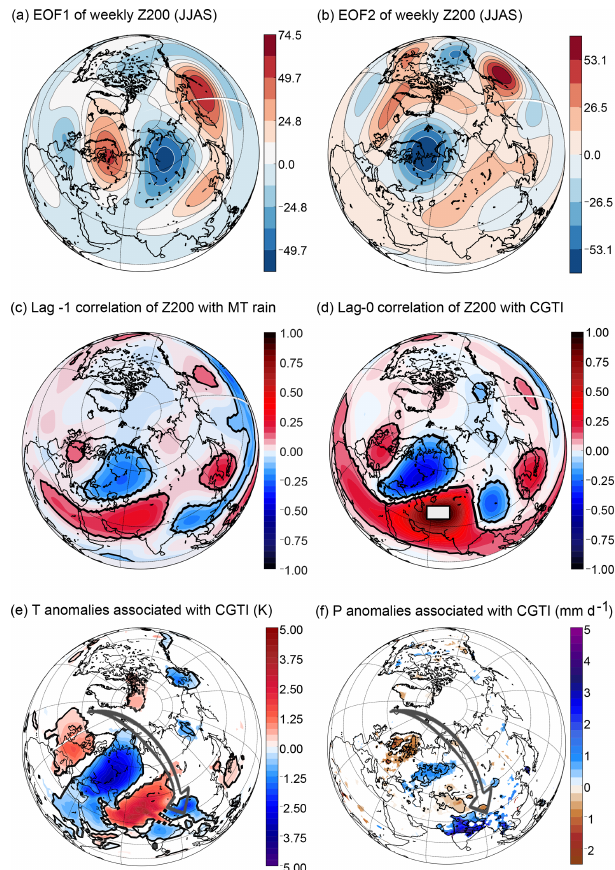
Figure 2. Mid-latitude variability associated with the ISM. (a, b) EOF1 and EOF2 expressed as covariance for the JJAS weekly Z200 field in the Northern Hemisphere (0–90 ◦ N, 0–360 ◦ E) for the period 1979–2017. (c) Correlation between weekly MT rain- fall (lag = 0) and Z200 (lag = − 1 week). (d) The CGTI region (white box) and the correlation between CGTI and Z200 (both at lag = 0), which forms the circumglobal teleconnection pattern. In panels (c) and (d) , correlation coefficients with a p value of p < 0 . 05 (accounting for the effect of serial correlations) are shown by black contours. (e) Composite temperature difference between weeks with CGTI > 1 CGTI SD minus weeks with CGTI < − 1 CGTI SD over the Northern Hemisphere. Panel (f) is as panel (e) but for rainfall anomalies from the CPC-NCEP dataset (as rainfall data for the Pai et al., 2015, dataset are available over India only) for the period 1979–2017. In panels (e) and (f) , anomalies with a p value of p < 0 . 05 (accounting for the effect of serial correlations) are shown by black contours, while grid points which are found sig- nificant only with non-corrected p values are